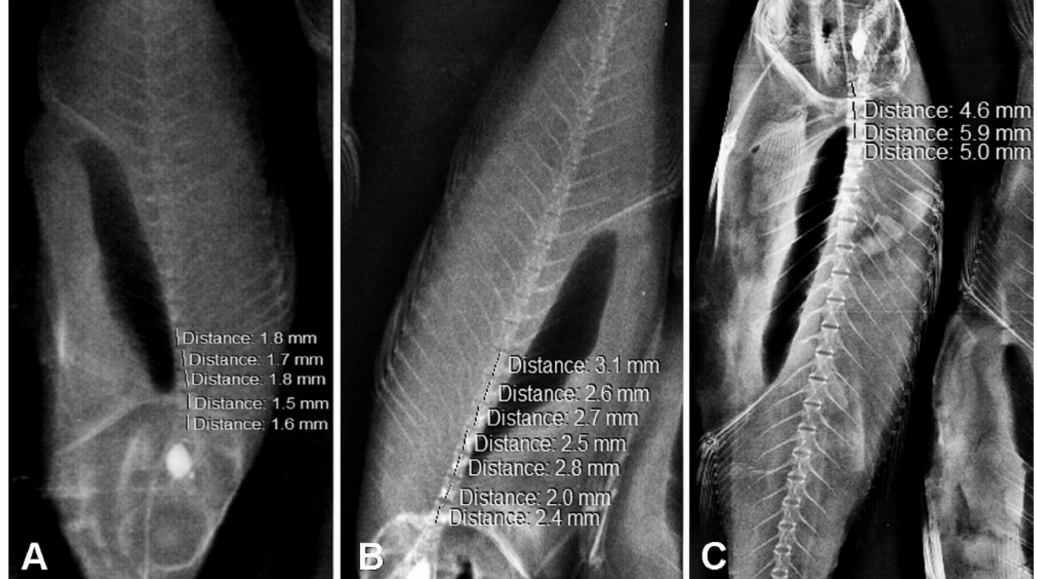
Figure 2. X-rays and vertebrae length measurements of ( A ) fingerling European seabass, ( B ) juvenile European seabass and ( C ) adult European seabass. Note: The mean lengths of the 24th vertebra (for individuals with 24, 25 and 26 vertebrae) for individuals within the same age group were similar ( p >